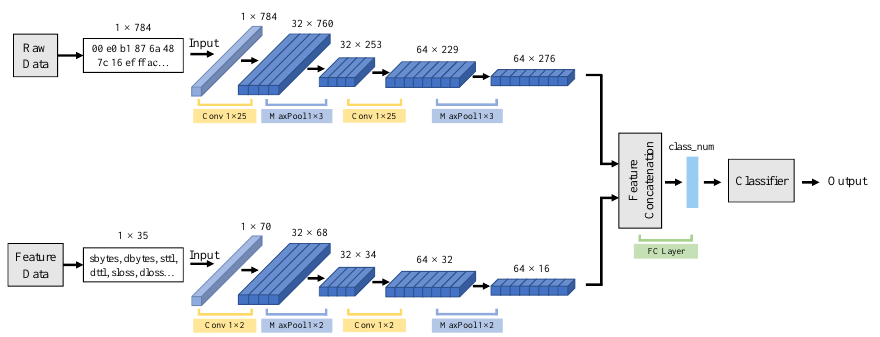
Figure 3. The structure of feature fusion. The fusion process occurs after the feature generation of detection